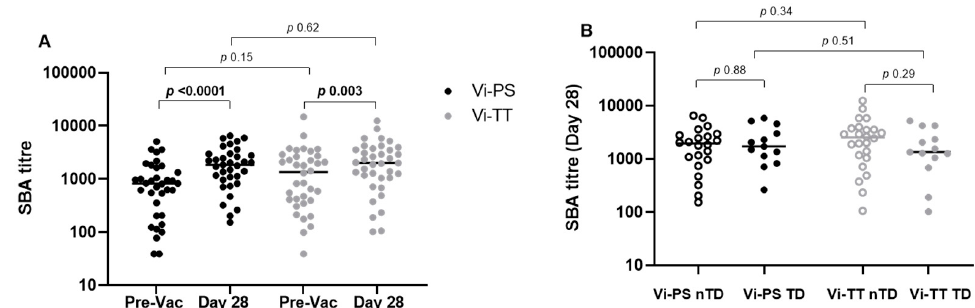
Figure 1. Serum bactericidal activity was evaluated prior to vaccination and 28 days post-vaccination in healthy volunteers who received either a Vi-PS or Vi-TT vaccine, before undergoing oral challenge with 1–5 × 10 4 CFU wild-type S. Typhi ( A ) Comparisons between time points, split by vaccine Vi-PS n = 35, Vi-TT n = 37. ( B ) Comparisons of day 28 titres, split by vaccine and challenge outcome (TD; typhoid diagnosed, closed circles. nTD; not typhoid diagnosed, open circles). Limit of detection is an SBA titre of 39. Between time point comparisons analysed using Wilcoxon matched-pairs signed rank test, between group comparisons analysed by